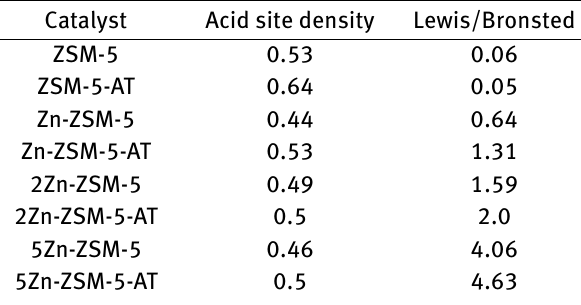
Table 15: Acid properties of catalysts [80]